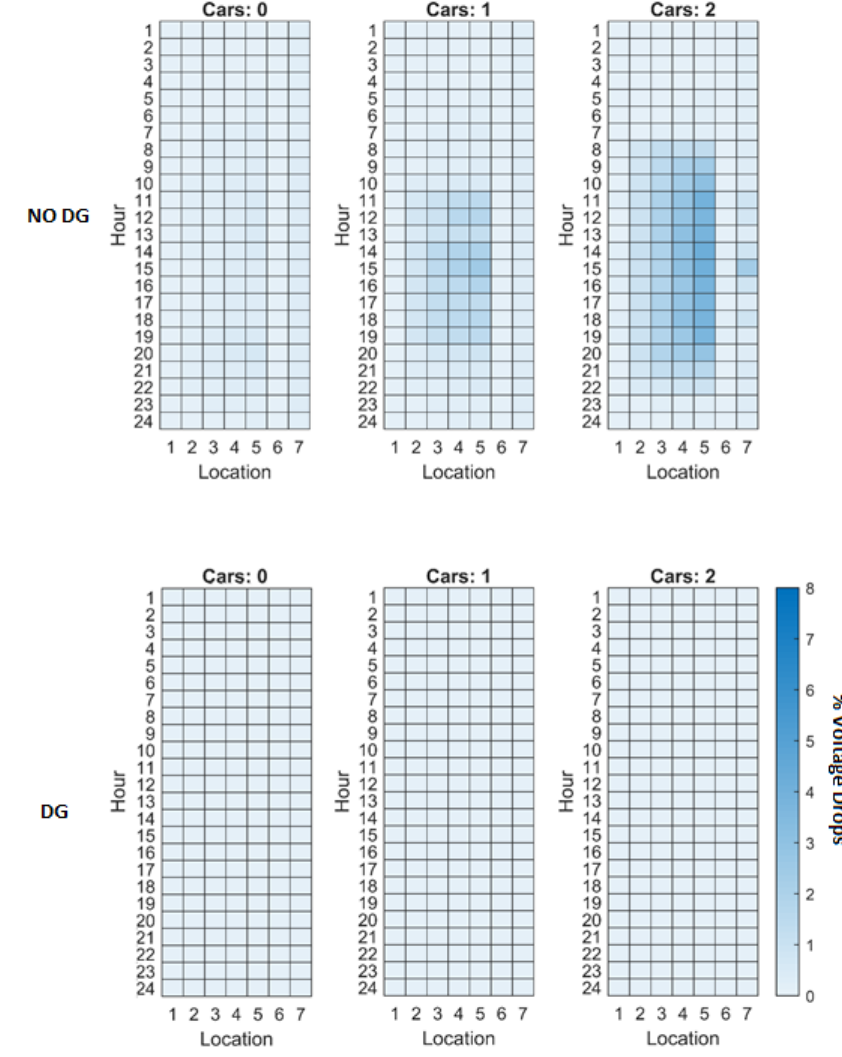
Figure A10. Maximum observed voltage drops (percentage) across the entire network (network 4), with and without distributed generation (DG).